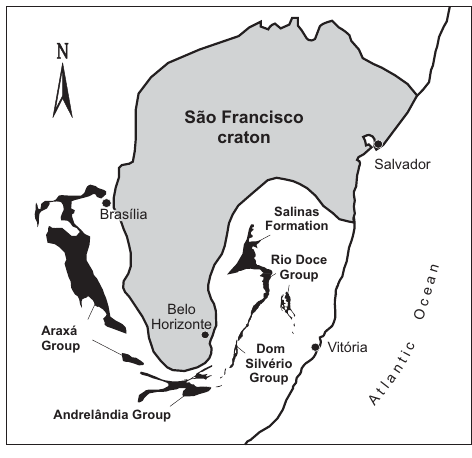
Fig. 9–Simplifiedmapshowingthelocalizationofthemetasedi-